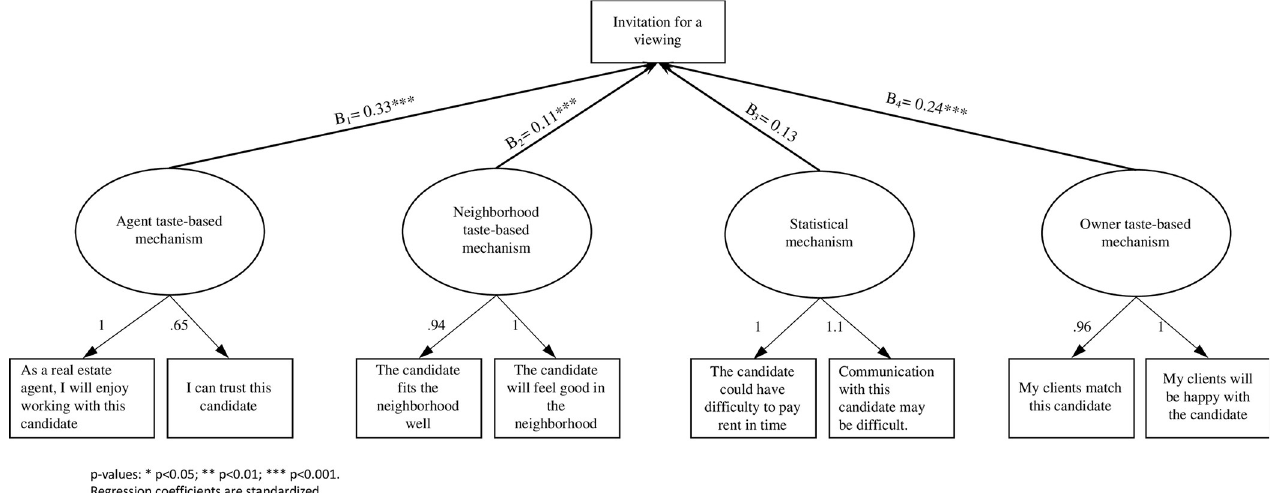
Fig 1. Structural equation model of the mechanisms of discrimination and the final decision (n = 576).